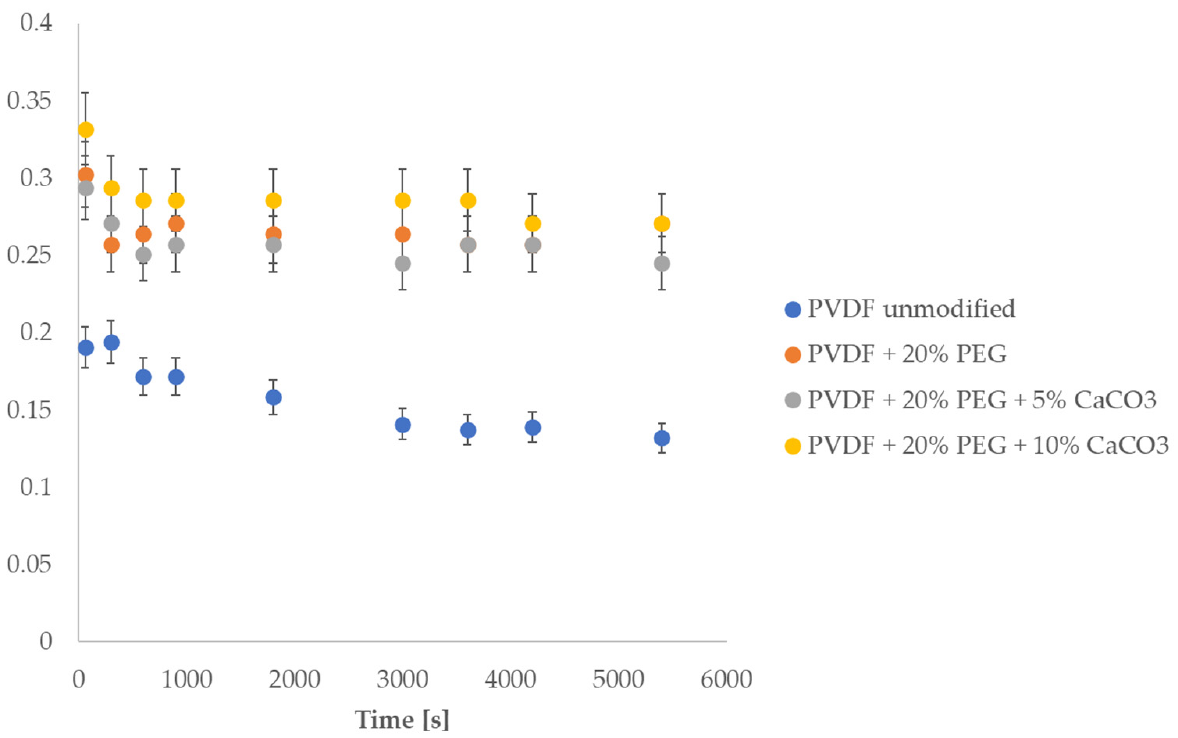
Figure 5. Change in permeate flux when running the process with Figure 5 . Change in permeate flux when running the process with sulfadiazine.